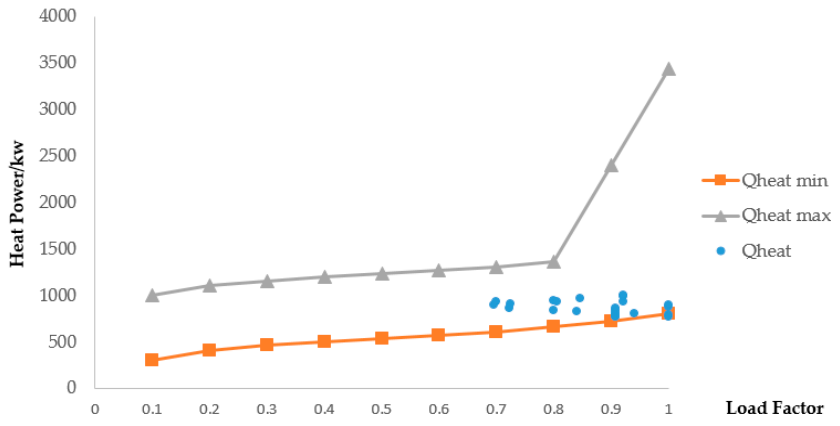
Figure 18. Single time scale heat load-load rate operation.